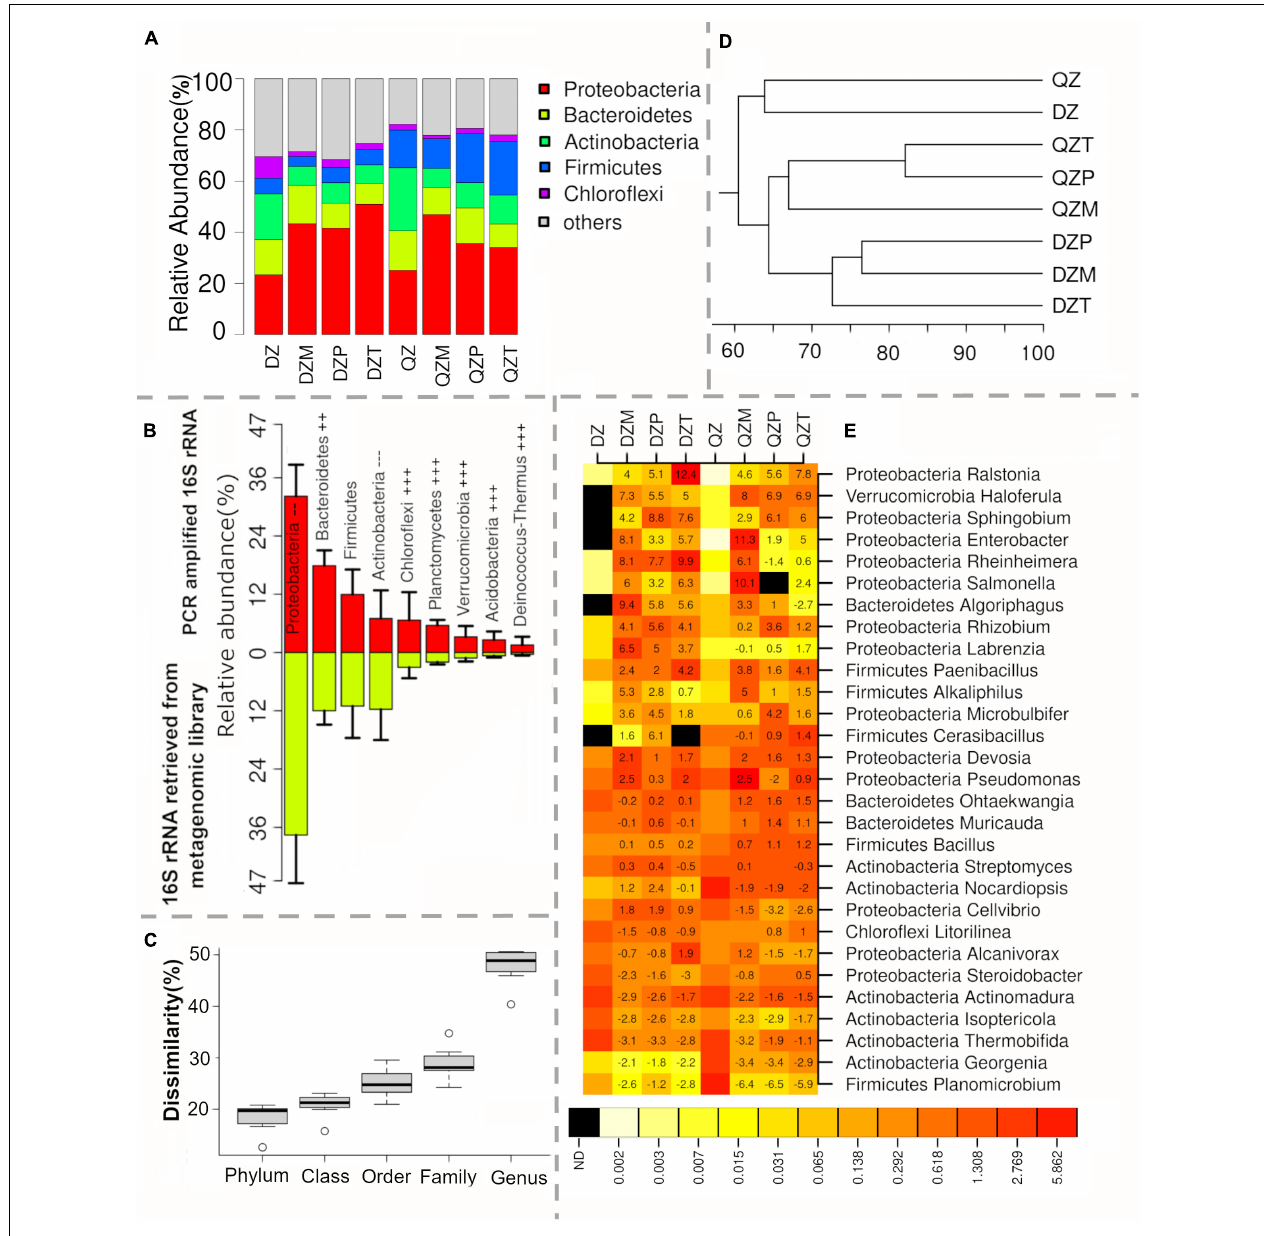
FIGURE 2 | Microbial community by the 16S rRNA sequences retrieved from shotgun metagenomics revealed relative abundance of different phylum in the rhizosphere of maize (M), pepper (P), and tomato (T) seedlings cultivated in cow manure compost (DZ) and chicken and cow manure co-compost (QZ) (A) , the discrepancy of 16S rRNA PCR amplicon sequencing on dominant phylum (B) and community composition at different taxonomic level (C) , separation on community composition by the UPGMA clustering analysis (D) , and dominant enriched genera in the rhizosphere. Numbers on the box indicate the level of enrichment by log2 of relative abundance of each taxon between rhizosphere and compost (E)